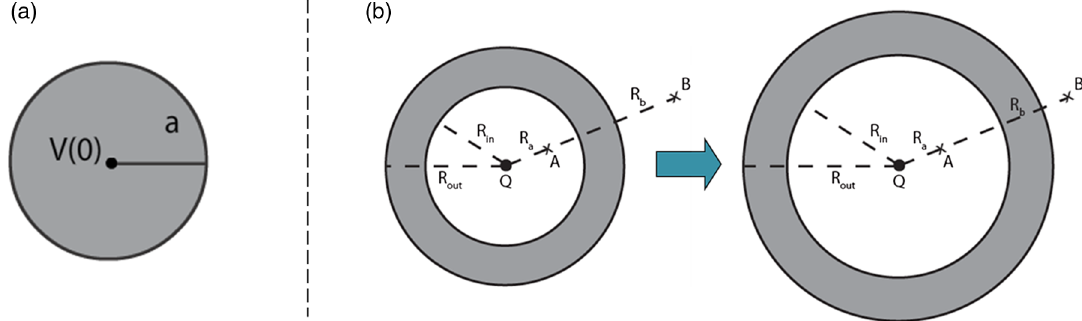
FIG. 10. Illustration of the two problems used in the multimeida tutorial. (a) Find the potential V ð 0 Þ at the center of a neutral conducting shell. The zero potential reference point is set at infinity. (b) A positive charge Q is enclosed in a conducting shell. What will happen to the potential difference between points A and B if the shell is enlarged?